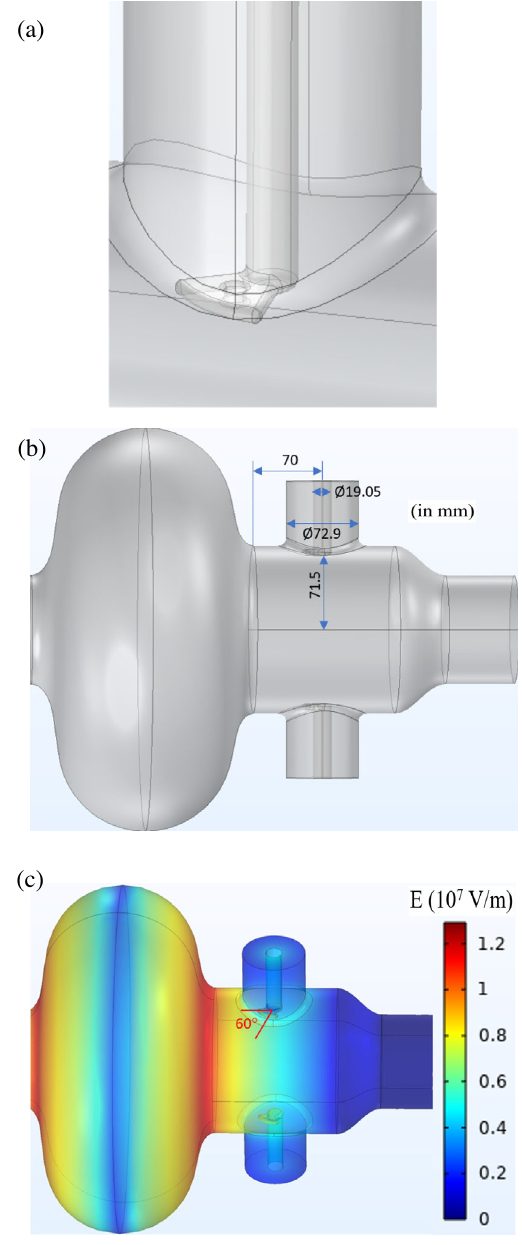
FIG. 9. Five-cell cavity coupler-side end-group (a) enlarged view of coupler antenna tip, (b) dimensions of power coupler port and antenna position, and (c) electric field distribution in the cavity end